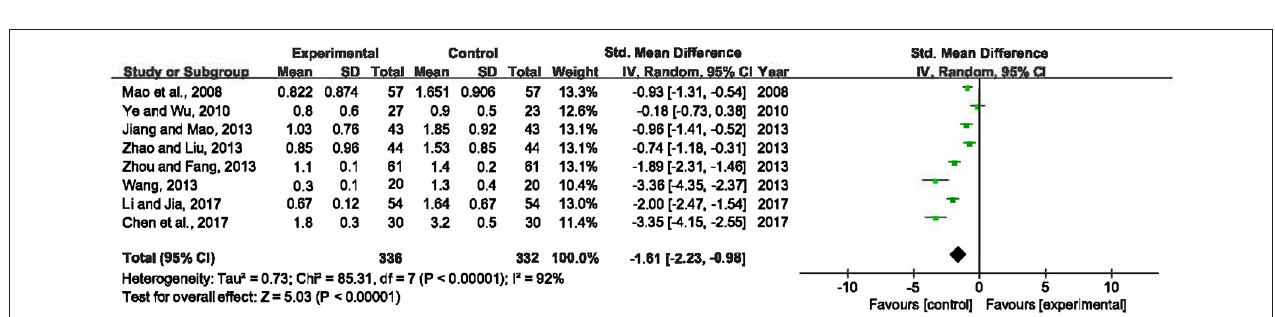
FIGURE 6 | Forest plot of APACHE II score in sepsis patients treated with XBJ + UTI therapy and UTI alone.